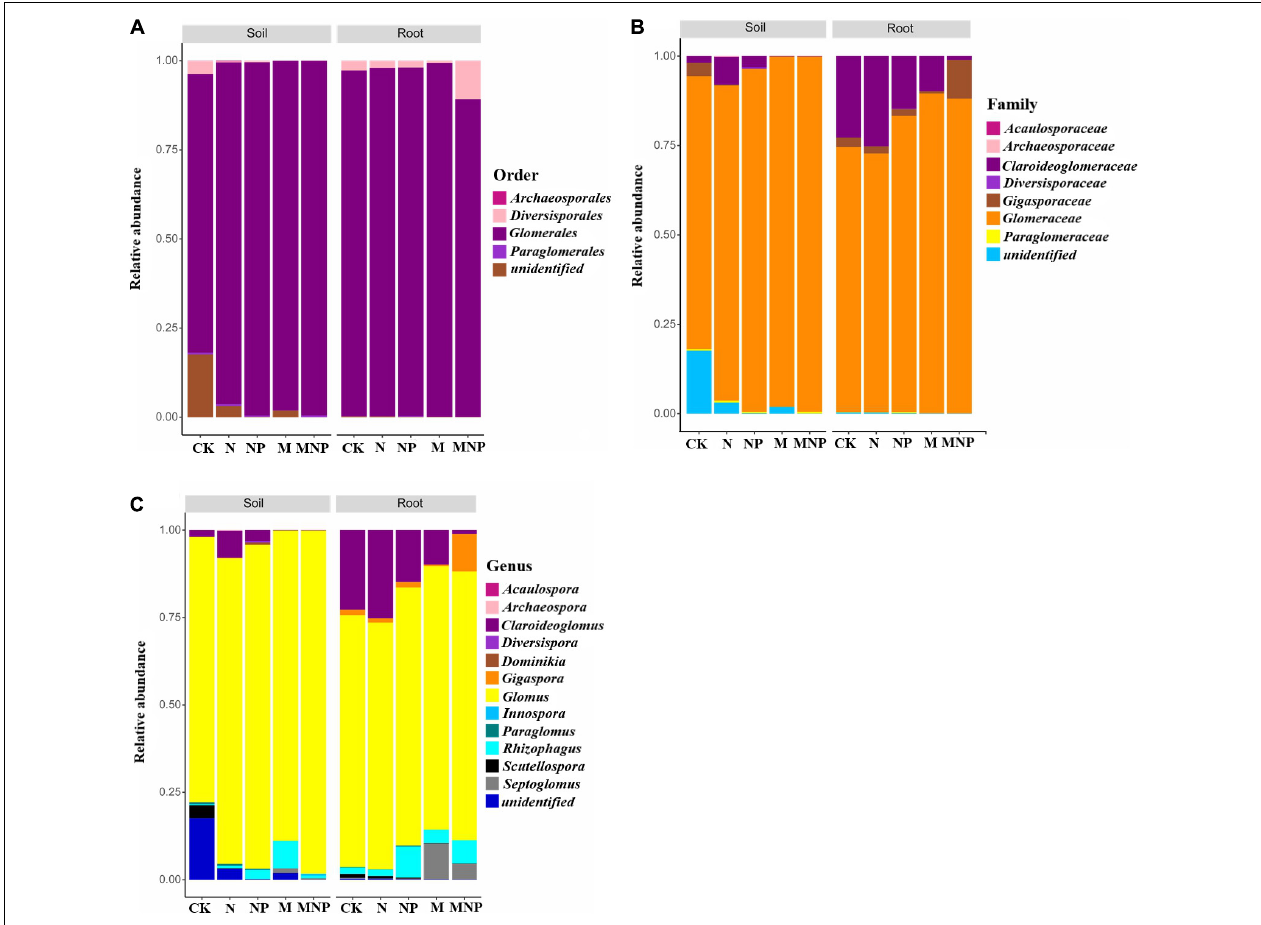
FIGURE 2 | Relative abundance of AMF communities at (A) order, (B) family, and (C) genus level in soil and maize roots under different treatments. CK, no fertilizer; N, mineral nitrogen fertilizer; NP, mineral nitrogen and phosphate fertilizer; M, pig manure; MNP, pig manure, mineral nitrogen, and phosphate fertilizer.